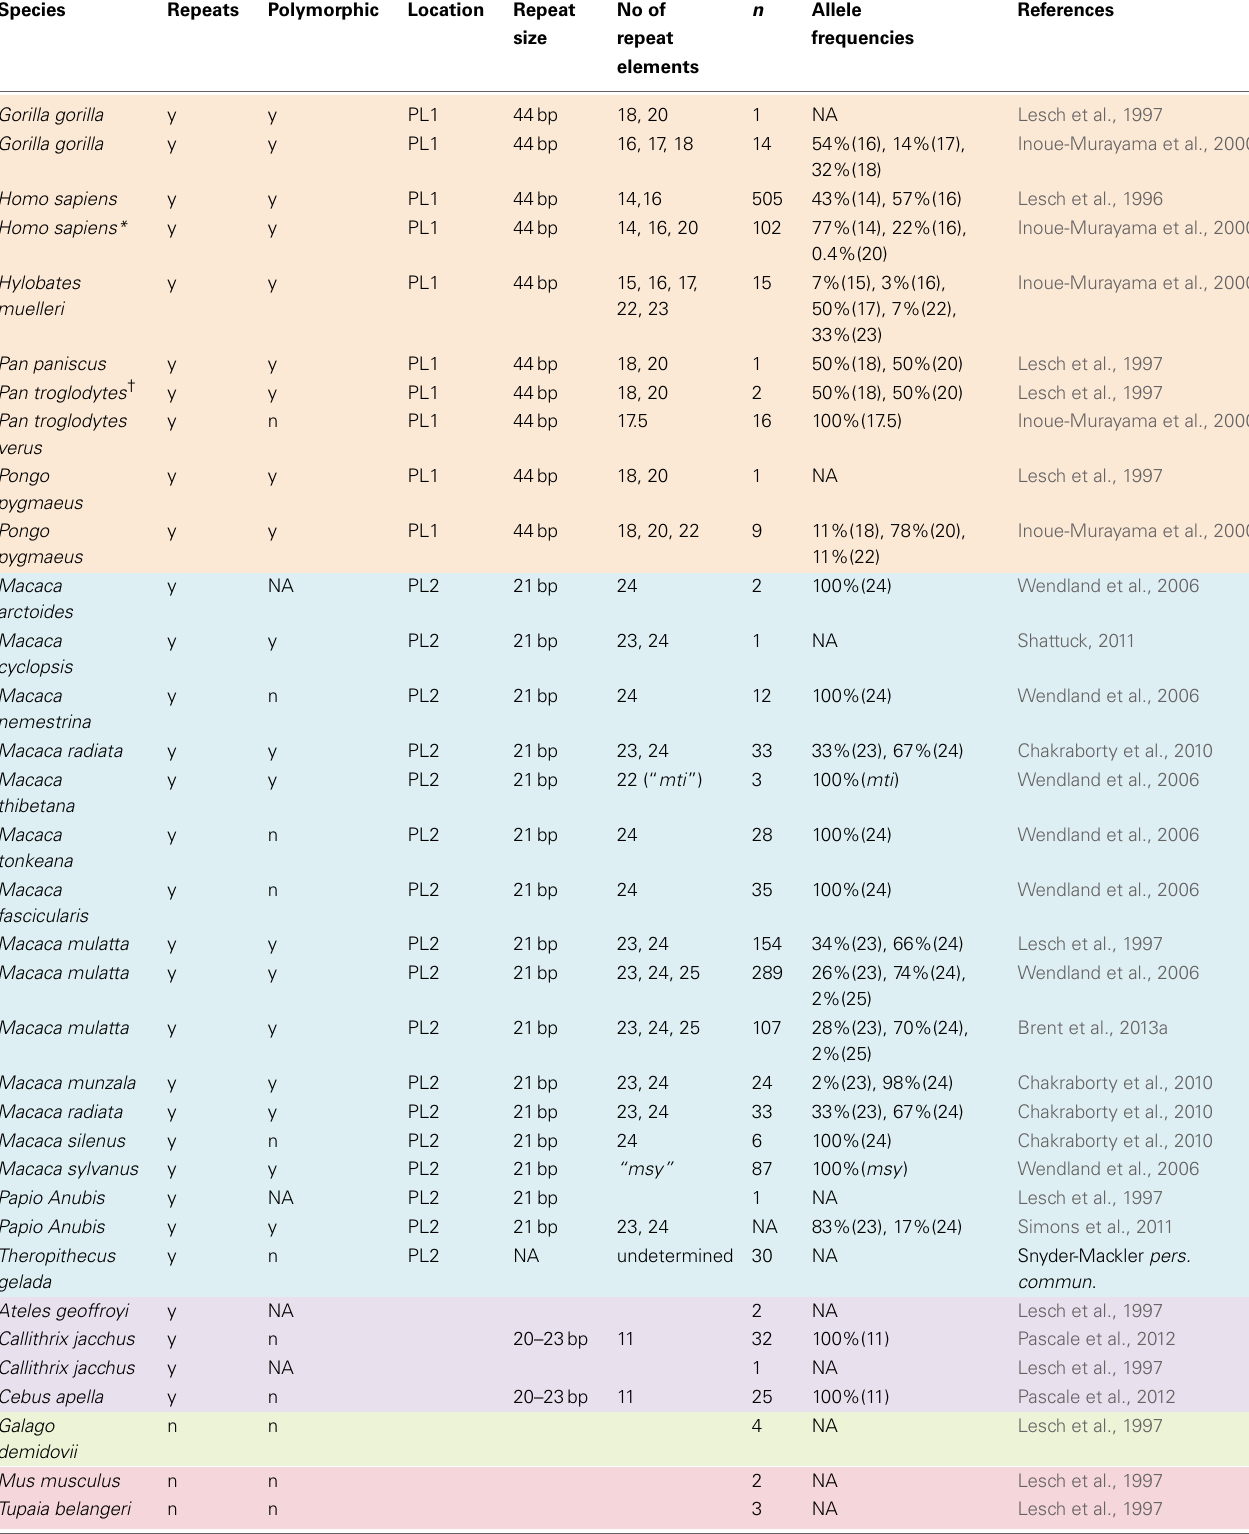
Table 1 | Summary of 5-HTTLPR polymorphisms in primates and other species.